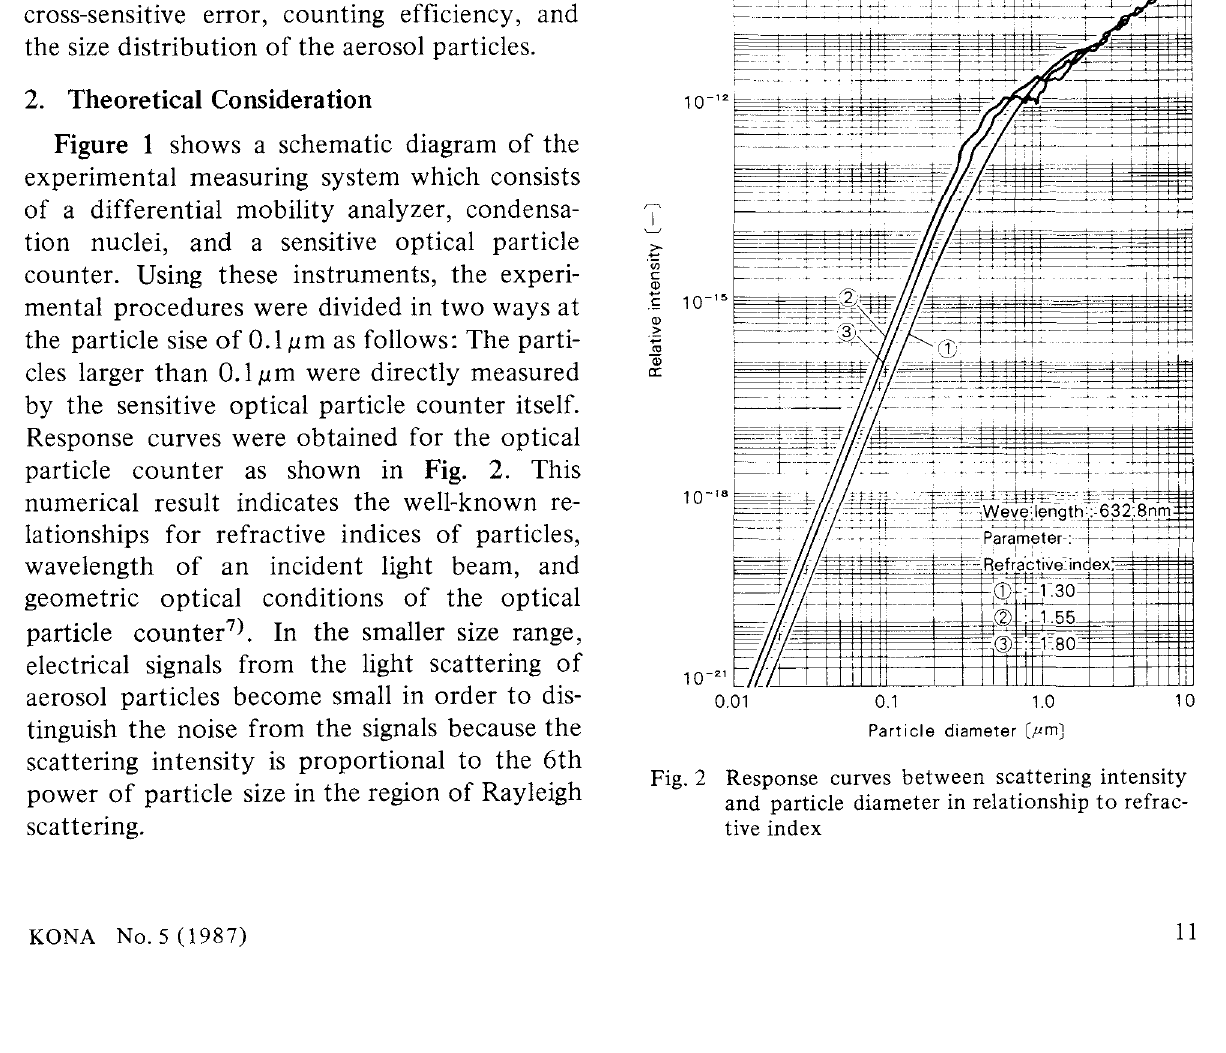
Fig. 1 Schematic diagram of the measuring system in the experiment